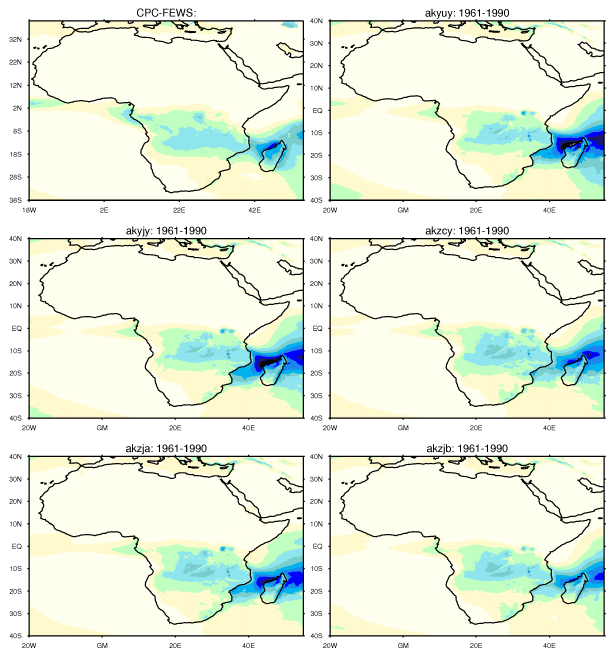
Figure 2. Comparison of the observed and simulated precipitation for Africa for the period June–September (JJAS). The observations are from CPC-FEWS (Love et al., 2004) cover the period 1983– 2012 while the simulations cover the 1961–1990.